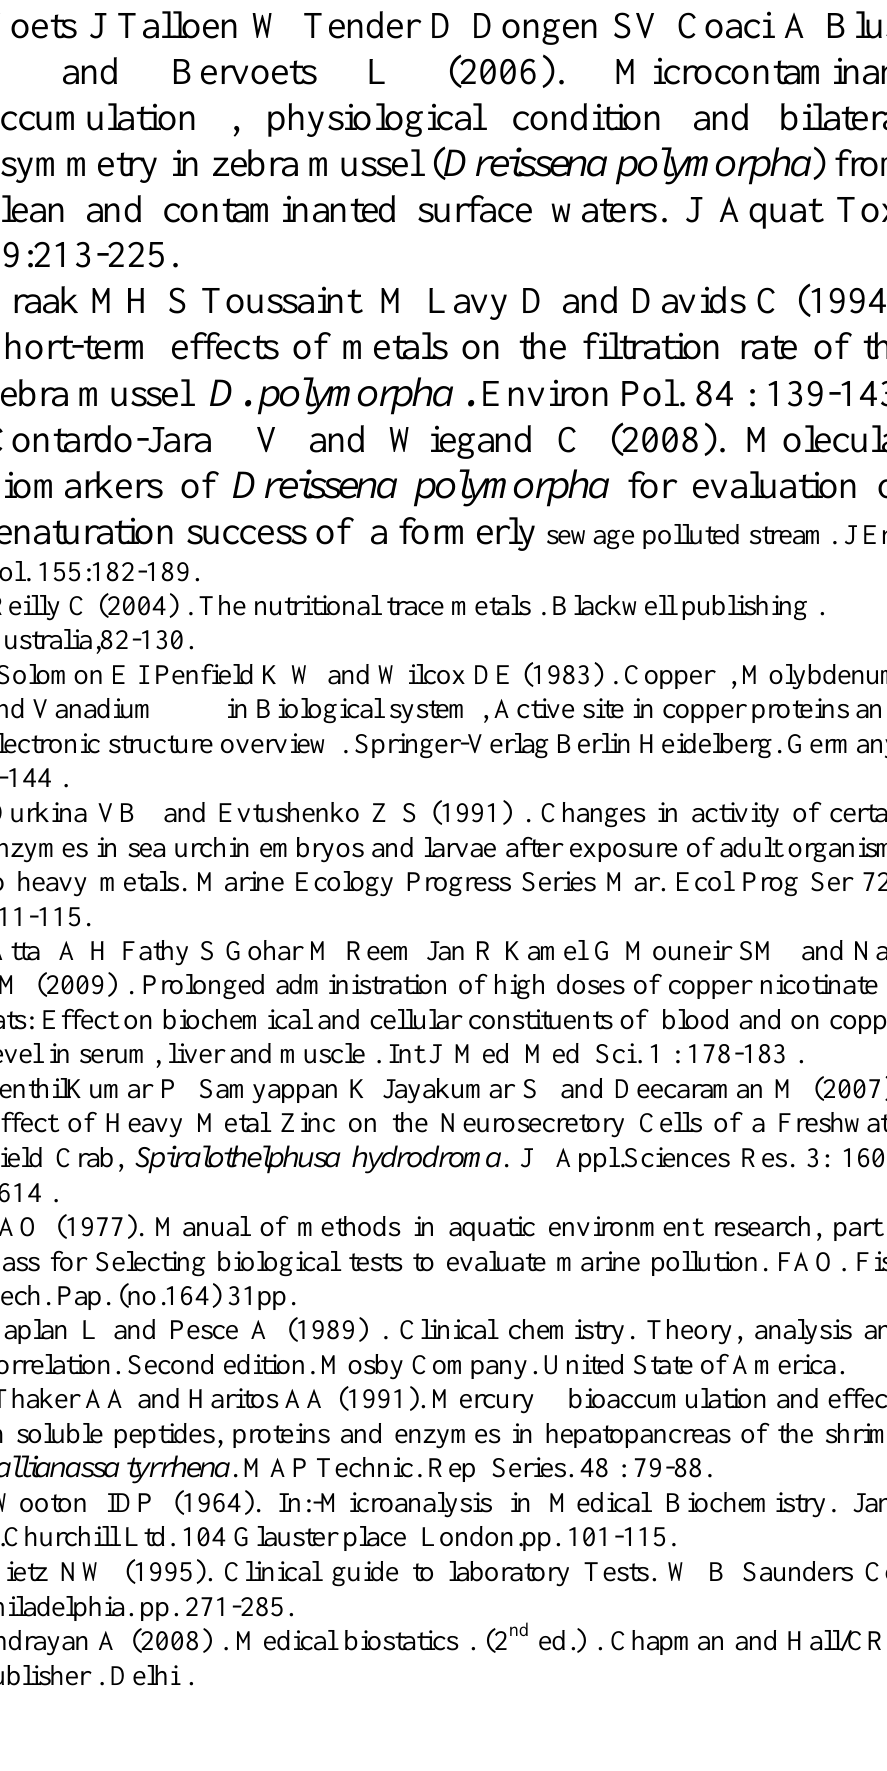
1- Voets J Talloen W Tender D Dongen SV Coaci A Blust R and Bervoets L (2006). Microcontaminant accumulation , physiological condition and